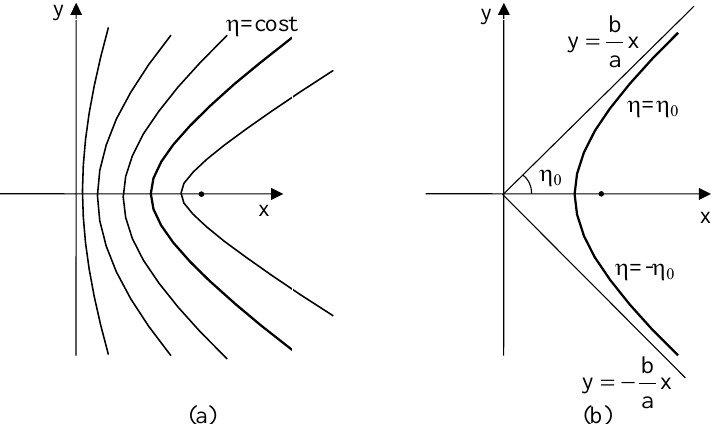
Figura 6: Famiglia di iperboli confocali (a); profilo iperbolico (primo e quarto quadrante) (b)